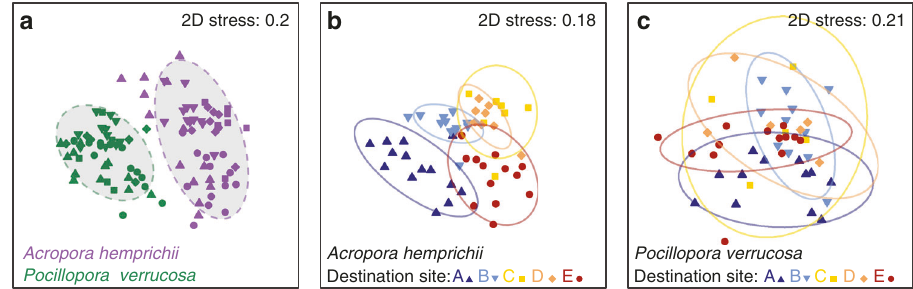
Fig. 2 Bacterial community structure and relative dispersion of the coral species A . hemprichii and P . verrucosa . All plots based on non-metric multidimensional scaling (nMDS) of Bray-Curtis distances of bacterial community compositions associated with coral samples (after 21 months of reciprocal transplantation). a corals A . hemprichii and P . verrucos a. b only coral A . hemprichii with sites indicated. c only coral P . verrucosa with sites indicated. A/B unimpacted sites; C/D local wastewater and nutrients sites; E municipal sewage and sedimentation and oil site. Ellipses denote 90% con fi dence intervals. Source data are provided as a Source Data fi le Table 2 Statistical overview over bacterial microbiome differences across sites Two-way PERMANOVA test statistics